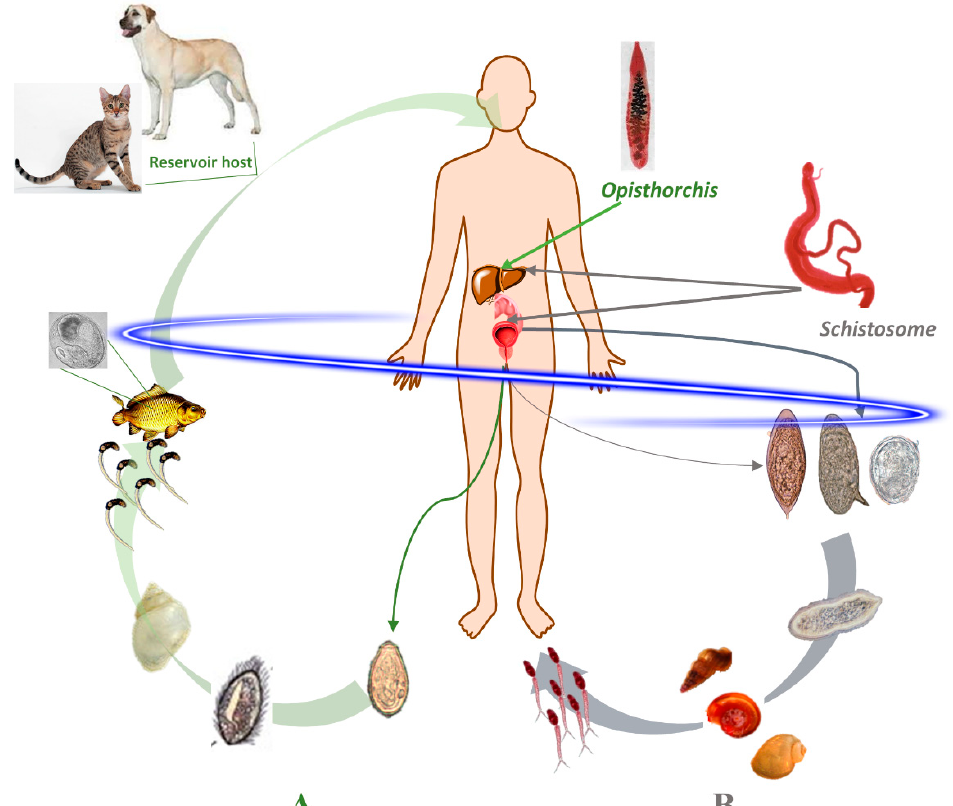
Figure 1. Life cycle of schistosomes (grey) and opisthorchiids (green). Both parasites have a complex life cycle involving two or more hosts. ( A ) The infection with Opisthorchis spp. occurs through ingestion of raw fish which contain metacercariae. Following ingestion, the metacercariae excyst in the duodenum and juveniles migrate into the biliary tract where they mature and lay eggs that are excreted through feces. Within the snail, the parasite undergoes an asexual reproduction phase which, in turn, produces the cercariae that are shed from the snail into the water, where they seek out and infect the fish. ( B ) Regarding schistosomes, the infection follows exposure of human skin to contact with water containing the cercariae. These larvae penetrate the skin, shed the tail in the dermis, and transform into the schistosomulum stage which migrates in the circulation. After several weeks, the adult schistosomes take up residence in the venous blood of the intestines or pelvic organs. The adult worms’ mate and proceed to release eggs that are excreted. The eggs hatch on contact with fresh water, releasing miracidia that infect suitable snails, and thereby complete the developmental cycle.